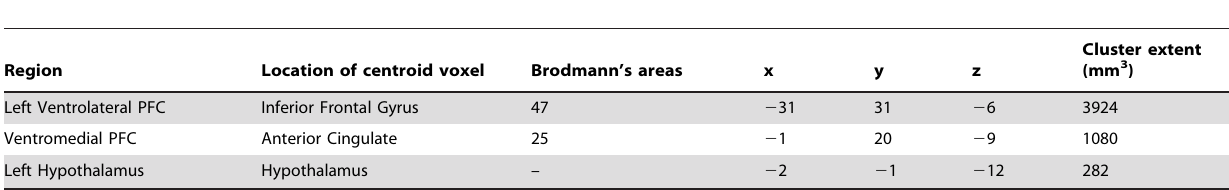
Table 3. Regions associated with reduced activity in association with social proximity.